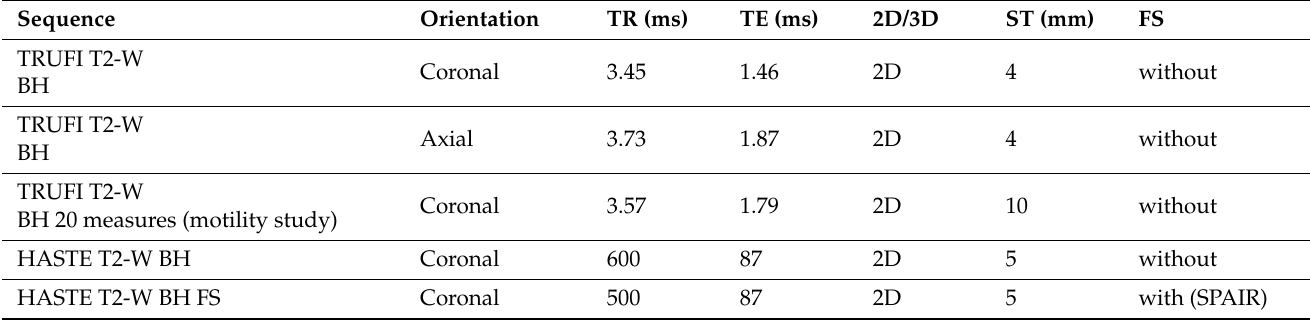
Table 1. Small bowel magnetic resonance imaging protocol for 1.5